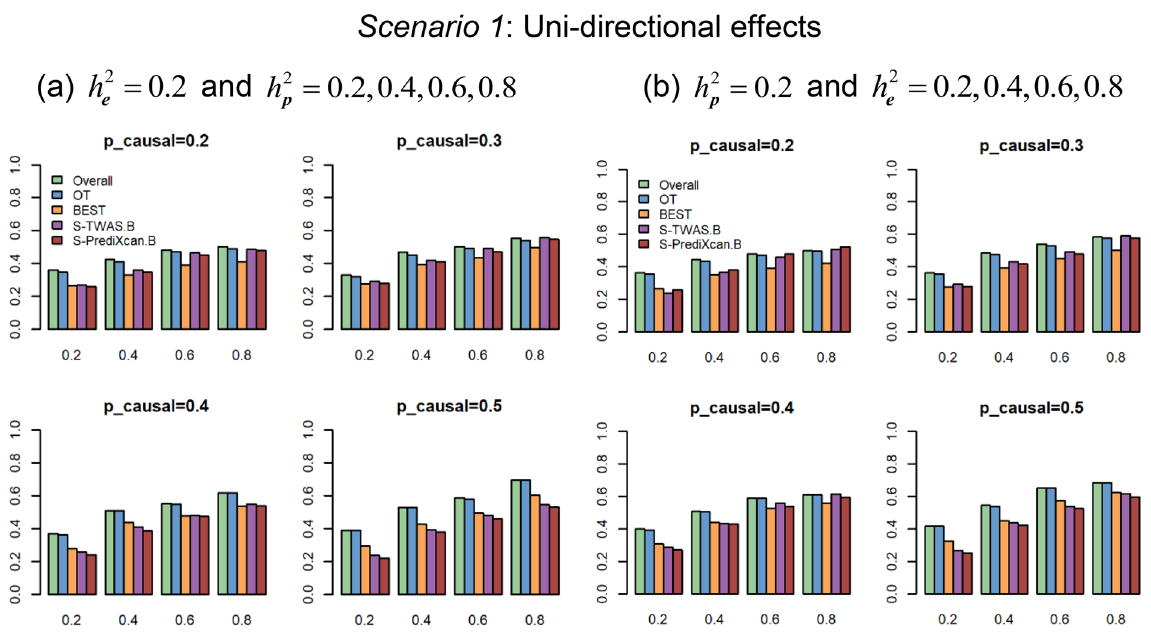
Figure 1. Power comparisons of gene-based association tests at 1.75 × 10 − 6 significance level under Uni- directional effects ( β 1 = β 2 = β 3 = β 4 ) with p causal = ( 0.2, 0.3, 0.4, 0.5 ) based on gene AGTRAP . ( a ) Estimated power against phenotypic heritability h 2 p with fixed expression heritability h 2 e = 0.2 ; ( b ) Estimated power against expression heritability h 2 e with fixed phenotypic heritability h 2 p = 0.2 .